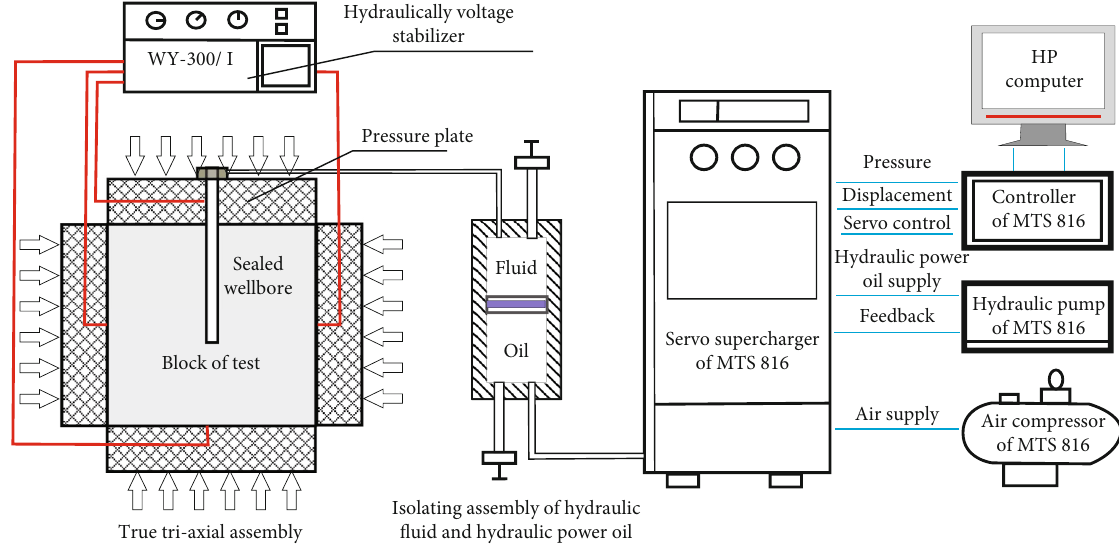
Figure 1: True triaxial volumetric fracing test